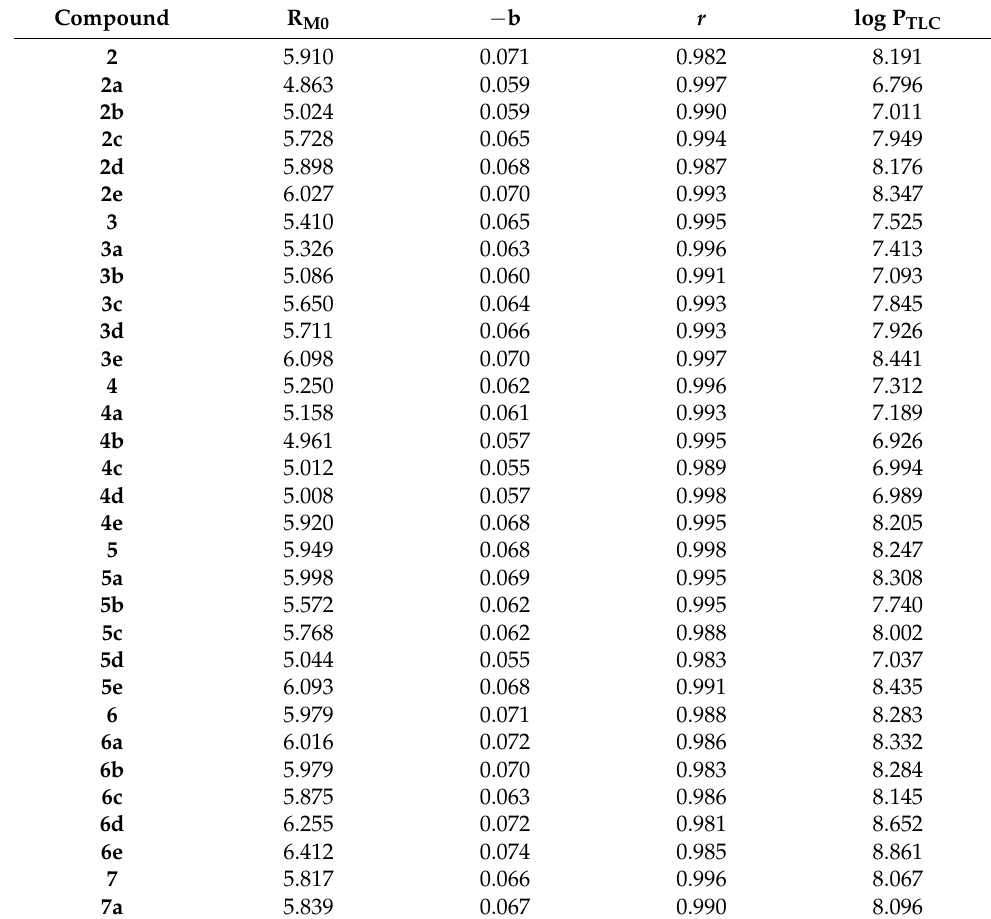
Table 8. The experimental values of lipophilicity for tested compounds.